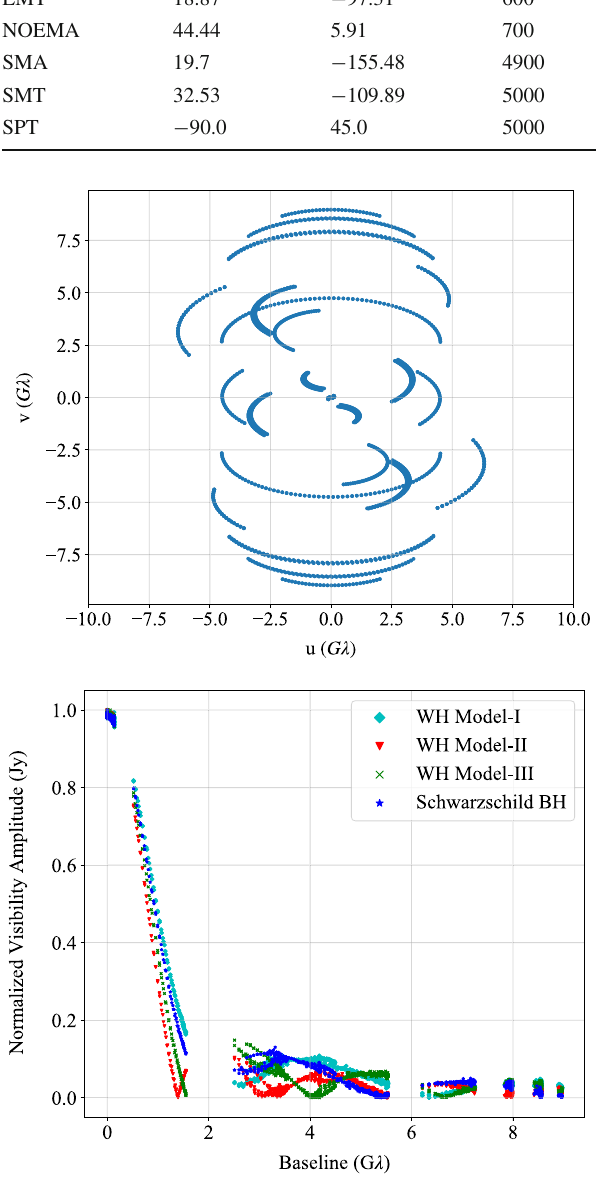
Fig. 6 Upper panel: U-V coverage for the EHT-2021 array configura- tion.Lowerpanel:Normalizedvisibilityamplitudesfortheobservations made for different WH geometries: Case I, Case II and Schwarzschild BH